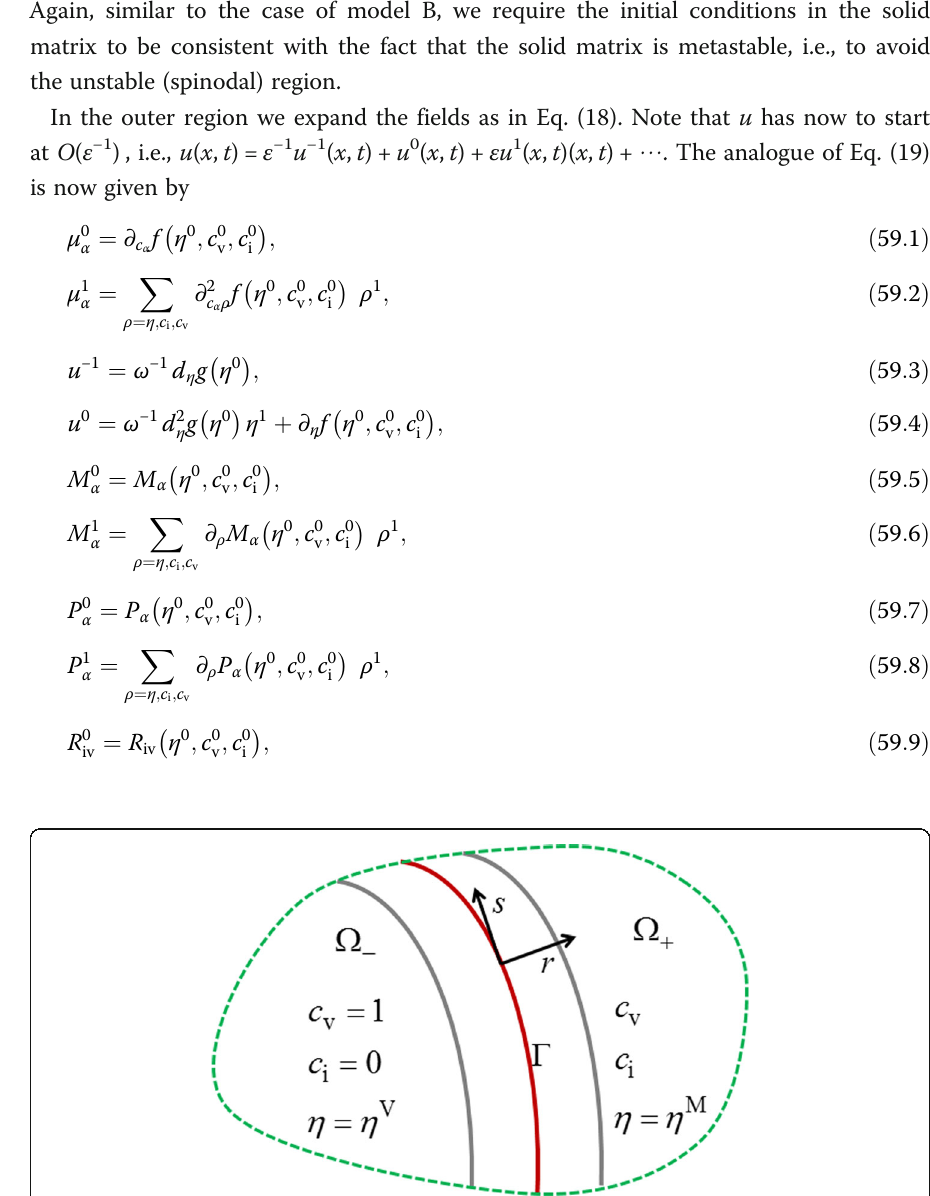
Fig. 3 A schematic illustration of the local coordinate system used in the asymptotic analysis of model C showing values of the order parameters across the void (free)